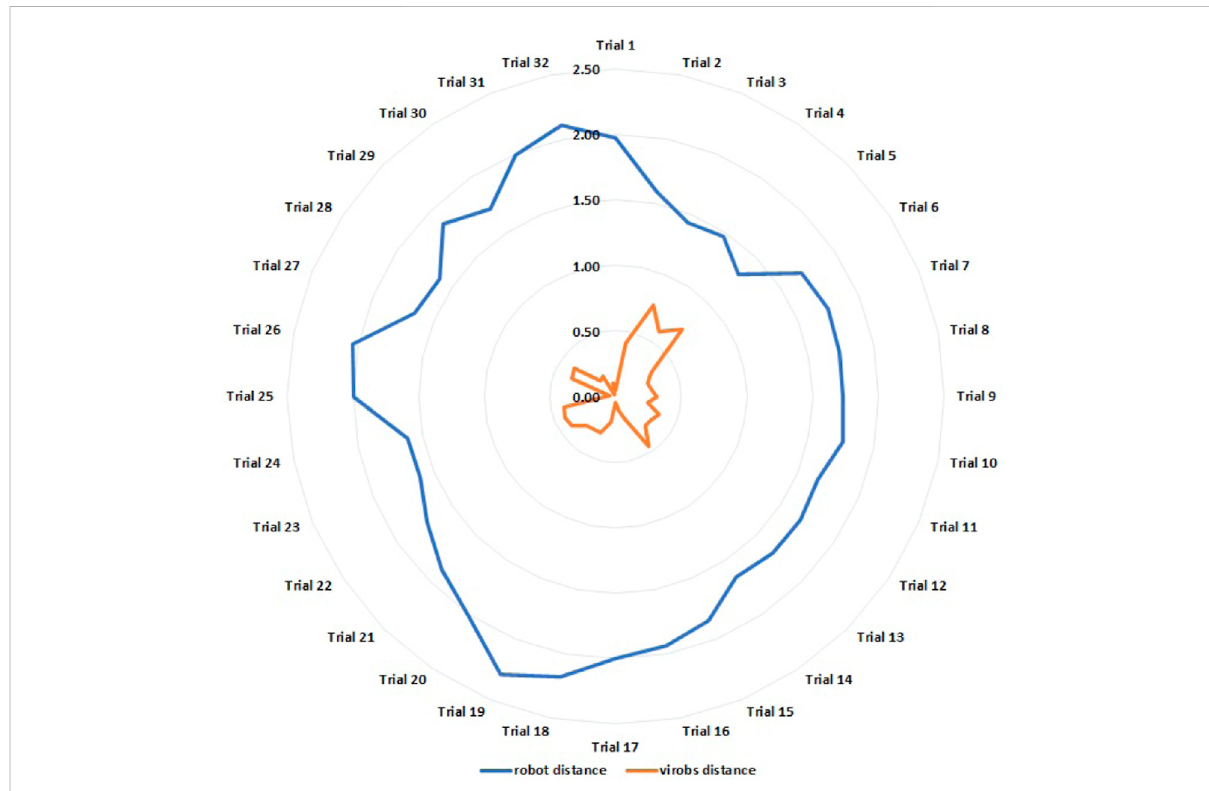
FIGURE 7 Task 2: estimation errors of the position of a single hole (orange) and relative robot distances (blue) during 32 trials (values in meters).